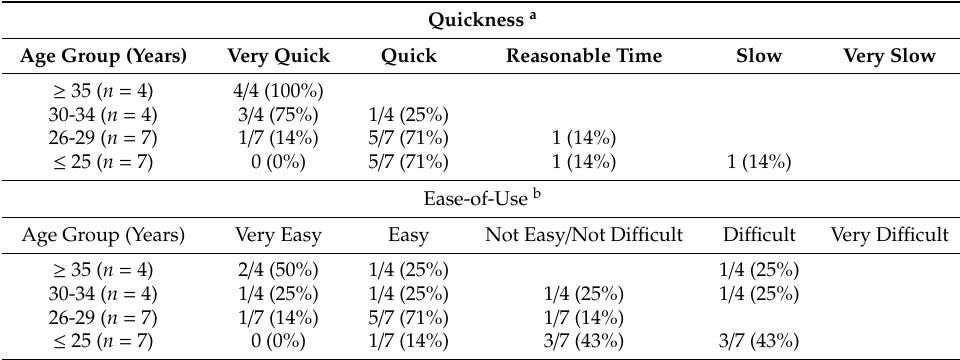
Table 6. The feasibility (quickness and ease-of-use) of the Equine Acute Abdominal Pain Scale (EAAPS) reported by first-time users by age group (proportion of responses in each category) (UK data only; n = 22; missing; n =